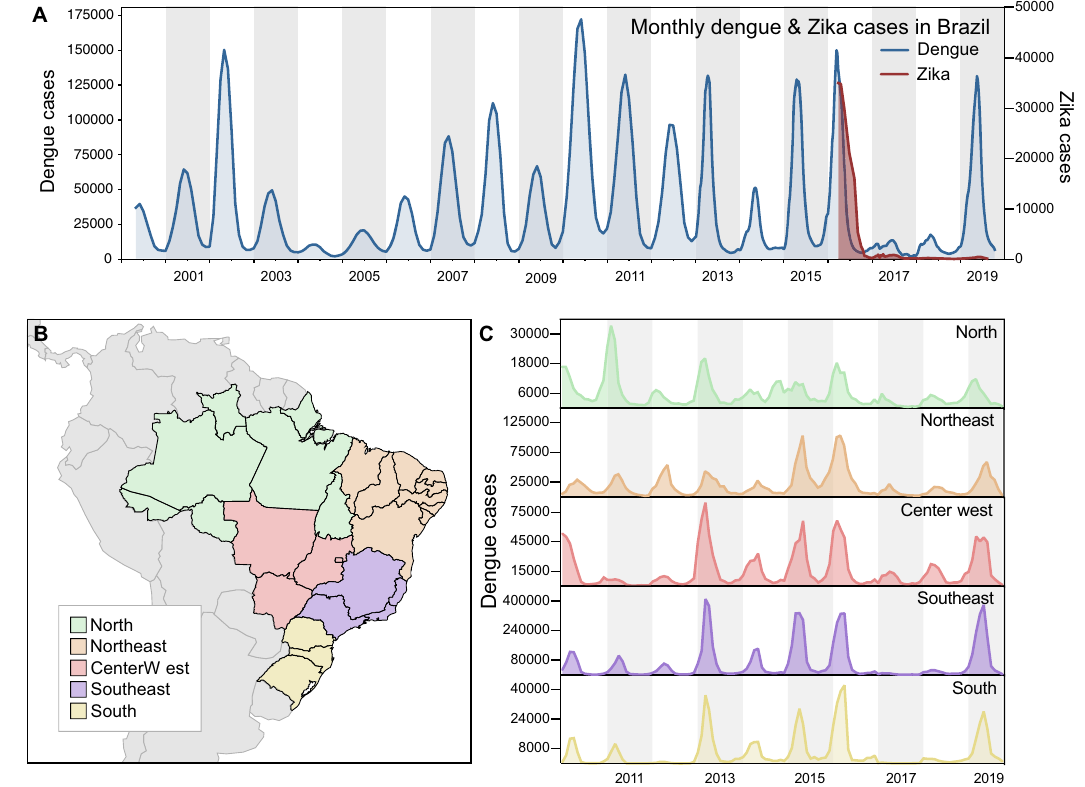
Fig. 1 Dengue resurgence in Brazil. A Monthly dengue and Zika cases in Brazil, from 2000 to 2019 ( y -axes not in the same scale). B Map of geographic regions in Brazil, with arrows highlighting two states included in our study: Paraíba, in Northeast Brazil; and São Paulo, in Southeast Brazil. C Dengue cases per geographic region in Brazil, from 2010 to 2019 ( y -axes not in the same